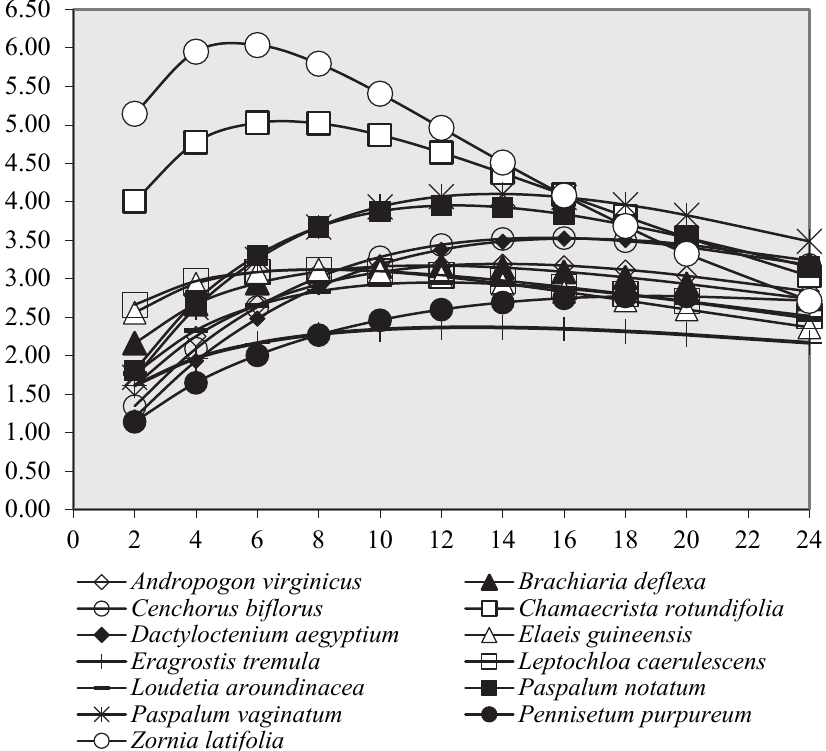
Figure 3. In vitro fermentation rate over time (24 h) for forage species. As final fermentation products, the total VFAs, ranging from 59.1 to 87.4 mM/g, was not statistically different ( p > 0.05) among species, and the branched ‐ chain fatty acids (iso ‐ butyrate and isovalerate) proportion was significantly ( p < 0.01) highest in E. guineensis (0.049 mM/g) and lowest in P. vaginatum (0.020 mM/g). The correlation between the IVGPT parameters and the chemical composition of the for ‐ age species (Table 4) confirmed the influence of the chemical composition on the fermentation parameters. The OM degradability was significantly ( p < 0.001) correlated with ash ( r = 0.67). The kinetic parameters (B, Tmax, Rmax) were significantly affected by the CP, EE, NDF, ADF, and ADL. The BCFA result significantly correlated to the CP ( r = 0.50, p < 0.01). Table 4. Significance of correlation between some chemical parameters and in vitro fermentation data ( n = 39). dOM